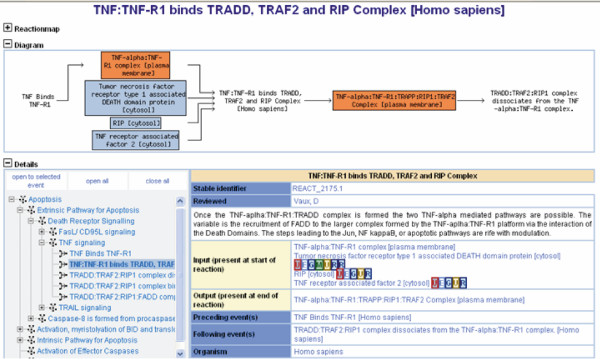
A reaction page.